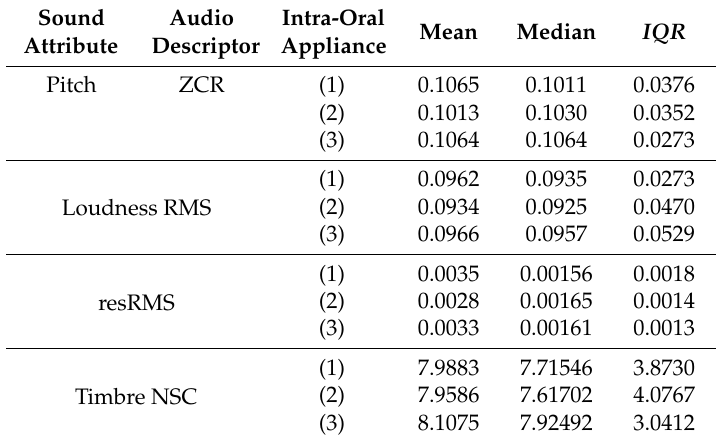
Table 2. Global statistics of the collected descriptor data per intra-oral appliance. The following number denotes the intra-oral appliances: (1) HACI, (2) TEATA, and (3) Customized Splint.